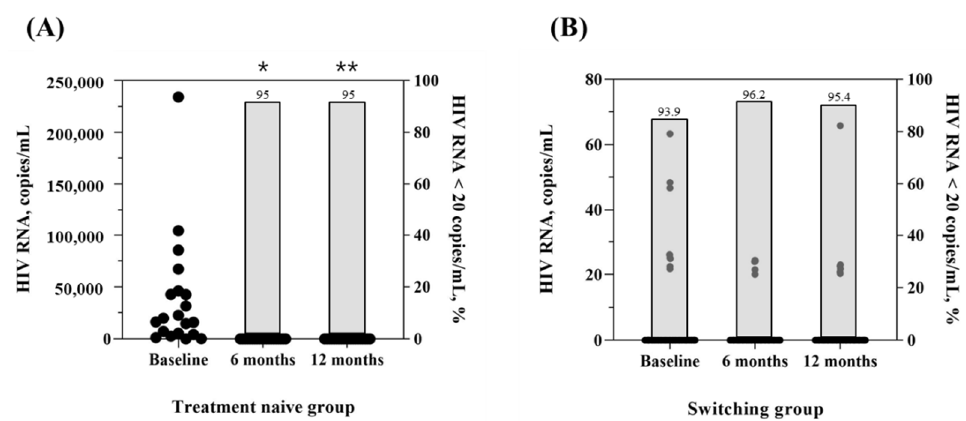
Figure 2. HIV RNA titer and proportion (%) of HIV RNA < 20 copies/mL in treatment naïve and switching group at baseline and 6- and 12-month follow-up after DTG/3TC treatment was started. ( A ) HIV RNA titer of the treatment-naïve group at baseline and 6- and 12-month follow-up; ( B ) HIV RNA titer of the switching group at baseline and 6- and 12-month follow-up. * p < 0.001 compared to the baseline. ** p < 0.001 compared to the baseline.